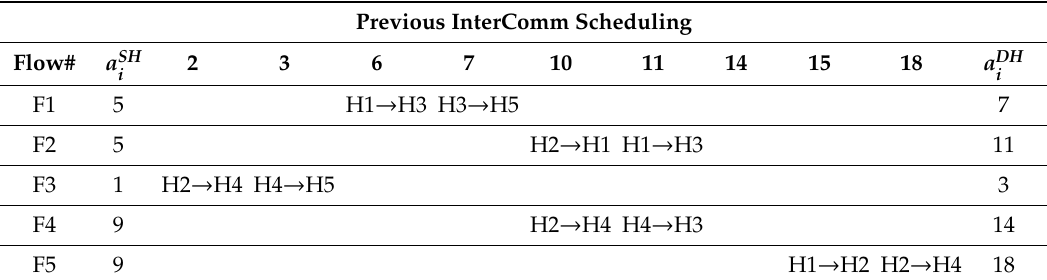
Table 2. Results of previous scheme InterComm scheduling of Figure 2.